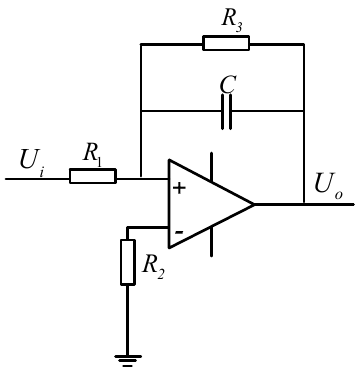
Figure 3. Structural schematic diagram of active feedback analog integrator.